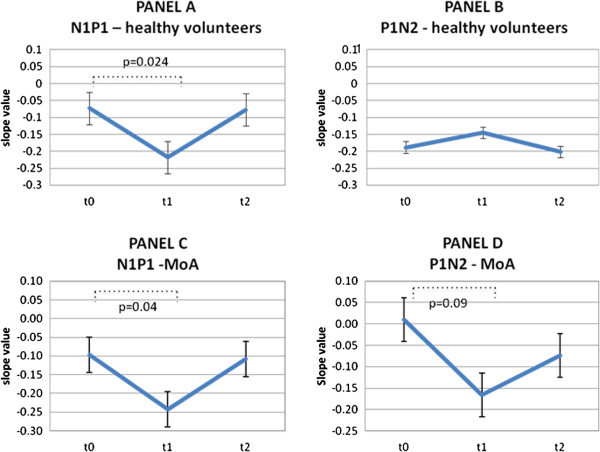
Time-dependent changes of habituation slope after anodal tDCS. From the up to the bottom of the table the changes on habituation slopes induced by anodal tDCS on N1P1 and P1N2 in healthy volunteers (HV, Panel A and Panel B) and episodic migraine patients (MoA, Panel C and Panel D) at T0, T1 and T2. The habituation value is expressed as the decrement of the response with stimulus repetition so a more negative value of the slope corresponds to a stronger habituation. The value of the slope at T0, T1, T2 was reported at every time point as it is obtained by the interpolation of mean values in all blocks by linear regression equation. The x axis corresponds to the time (T0 = baseline; T1 = immediately after the stimulation; T2 = after 3 hours).